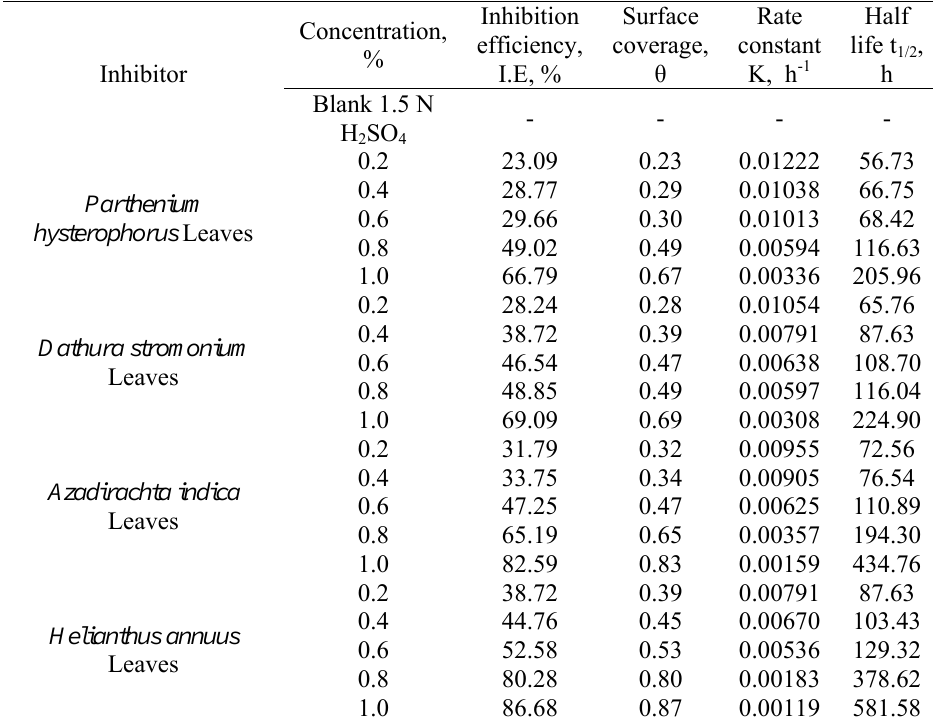
Figure 1. Inhibitor concentration vs rate constant Table 1. Effect of plant biomasses on mass loss data for corrosion of mild steel in 1.5 N H SO at 300 2 4